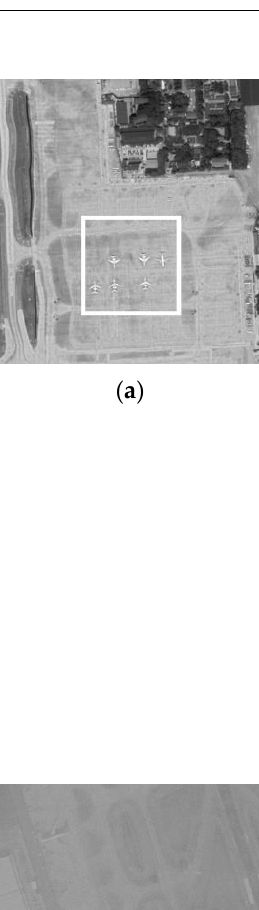
Table 2. Results of the comparative experiment.